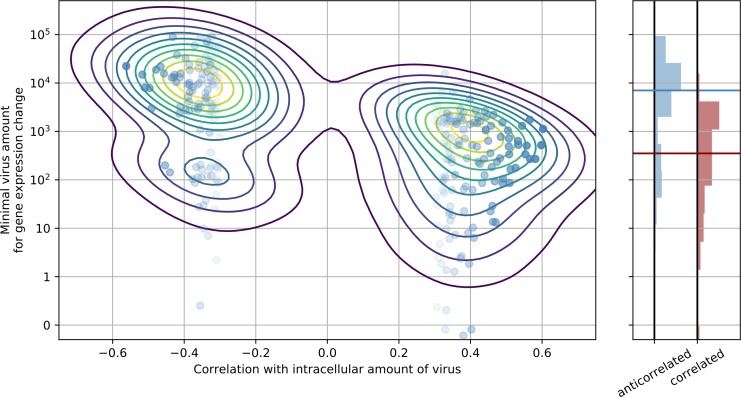
Genes that are anticorrelated with intracellular virus amount change expression at a higher threshold than genes that are positive correlated.This result is indicative that underexpression of cytoskeleton and metabolic genes mostly follows increased expression of ER stress response genes, and not vice versa. In the left panel, threshold is scattered against correlation with virus amount (each dot is a gene), limited to strongly anticorrelated or correlated genes. A gaussian kernel density estimate is overlayed as contour lines. In the right panel, histograms of thresholds (see Methods) and their medians for anticorrelated or correlated genes are shown, respectively.